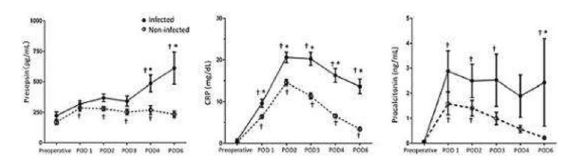
Fig. 1 (abstract 0238). Changes in Presepsin, CRP, and Procalcitonin There were significant differences between groups of presepsin, CRP,